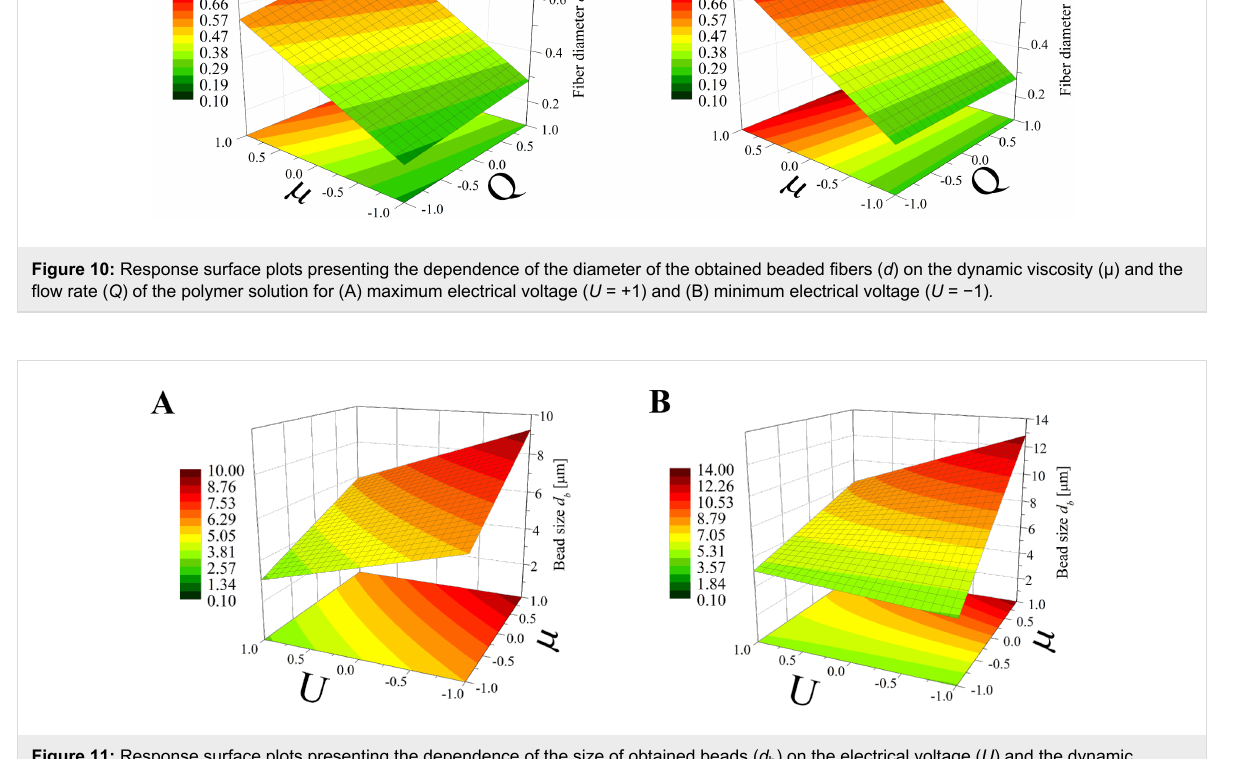
Figure 11: Response surface plots presenting the dependence of the size of obtained beads ( d b ) on the electrical voltage ( U ) and the dynamic viscosity (µ) of the polymer solution for (A) minimum flow rate ( Q = − 1) and (B) maximum flow rate ( Q = +1).